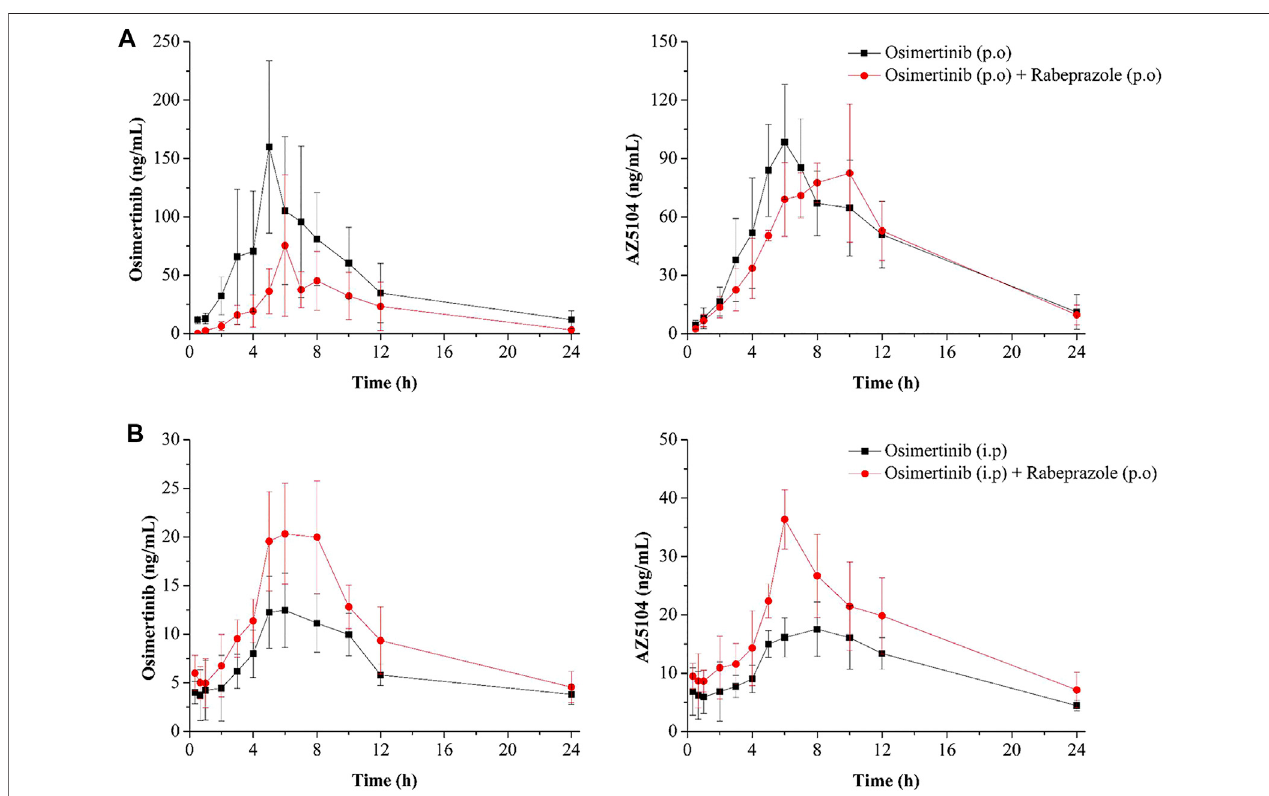
FIGURE5| Meanconcentration – timecurveofosimertinibandAZ5104. (A) Osimertinib(p.o.)andosimertinib(p.o.)withrabeprazole(p.o.). (B) Osimertinib(i.p.)and osimertinib (i.p.) with rabeprazole (p.o.). Data are presented as the means ± SD, n = 6.